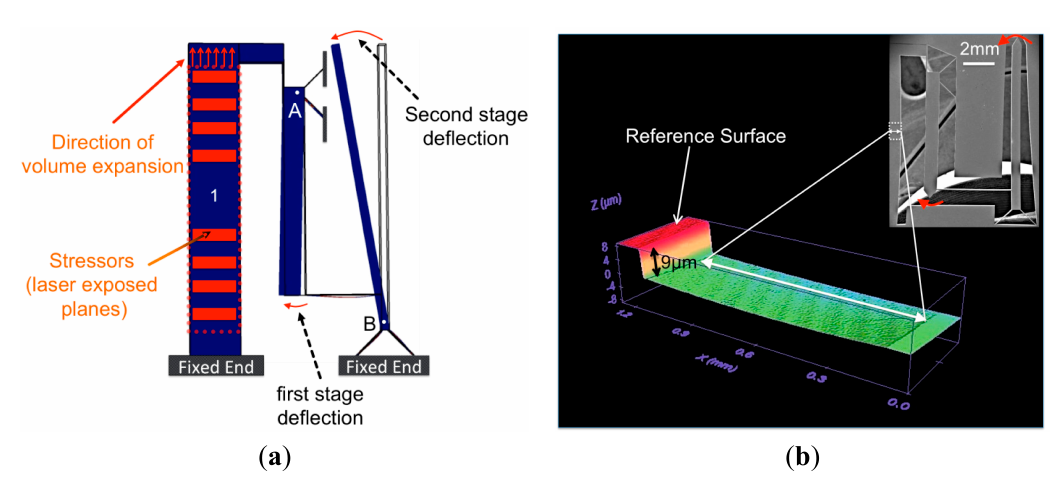
Figure 6. ( a ) A finite element analysis of the deformed system is illustrated. The same mechanism used for the amplification of the strain in the tensile tester is also used stand-alone (attached only to bulk fused silica-bar 1) for the quantitative evaluation of the stressors model. The red boxes in bar 1 represent the machined stressors. ( b ) Using white light interferometry for measuring the profile of the deformed device, a significant volume variation was found and attributed to out-of-plane motion.